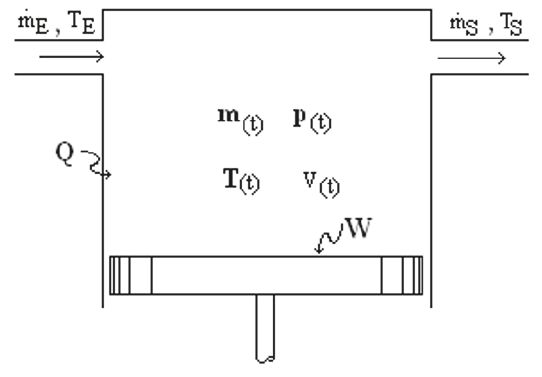
Figure 5: Generalised